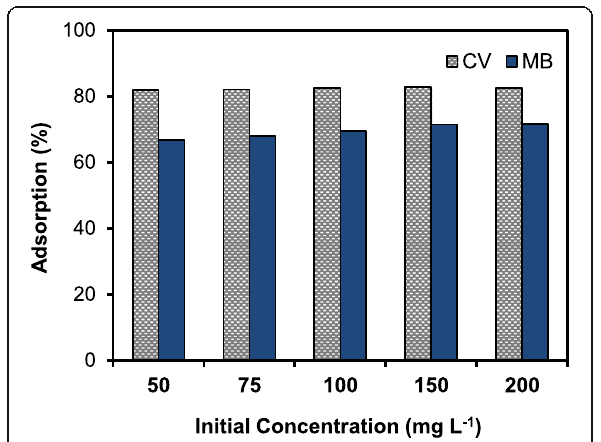
Fig. 8 Simultaneous adsorption of CV and MB dyes on ASS adsorbents (adsorbent dose of 50 mg, volume of adsorbate of 20 mL, concentrations of the adsorbate mixture are 50 – 200 mg L − 1 , contact time of 60 min, pH of 8, and temperature of 27 °C)